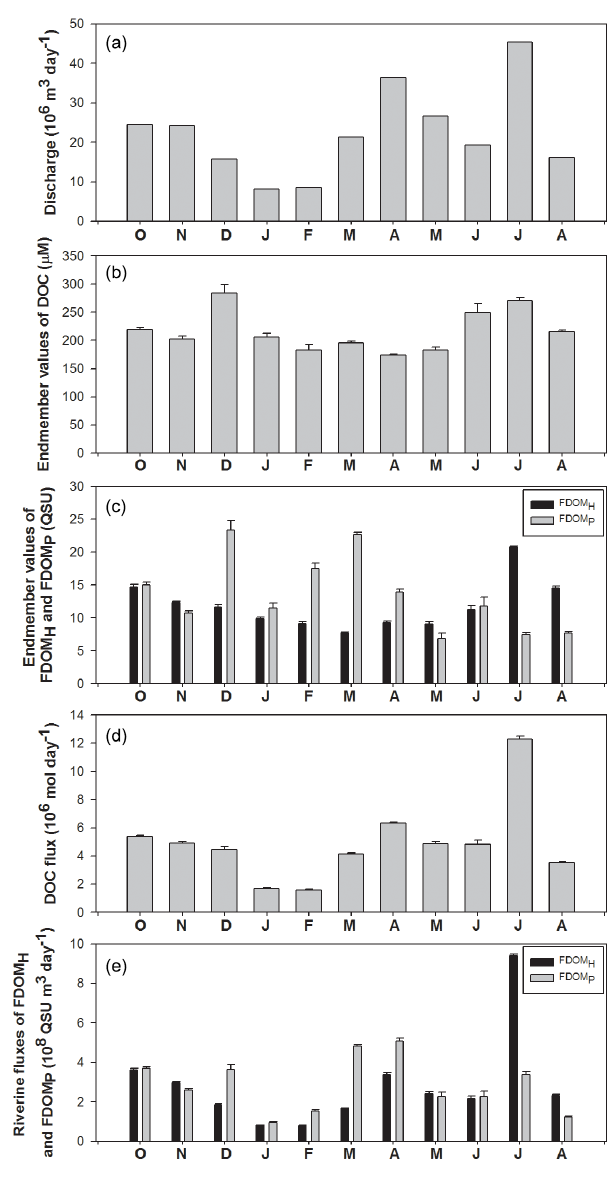
Figure 4. Temporal variations in discharge volumes, the end- member values of DOC, FDOM H , and FDOM P , and riverine fluxes of DOC, FDOM H , and FDOM P in the Nakdong River Estuary from October 2014 to August